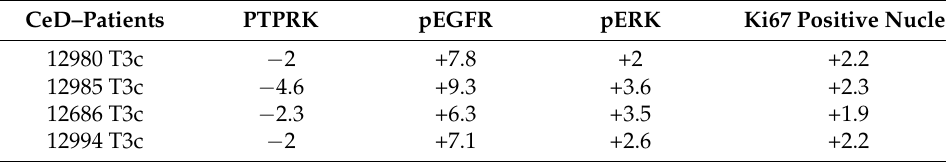
Table 4. Quantitative values of an increase or a decrease in CeD patients’ biopsies.